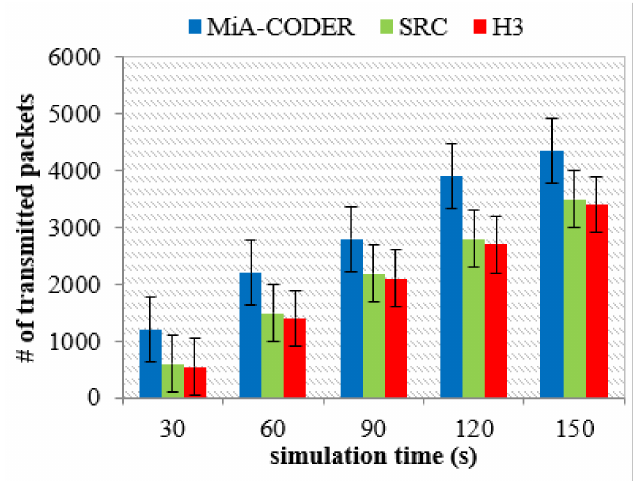
Figure 13. Number of transmitted packets (after coverage hole repair) vs. simulation